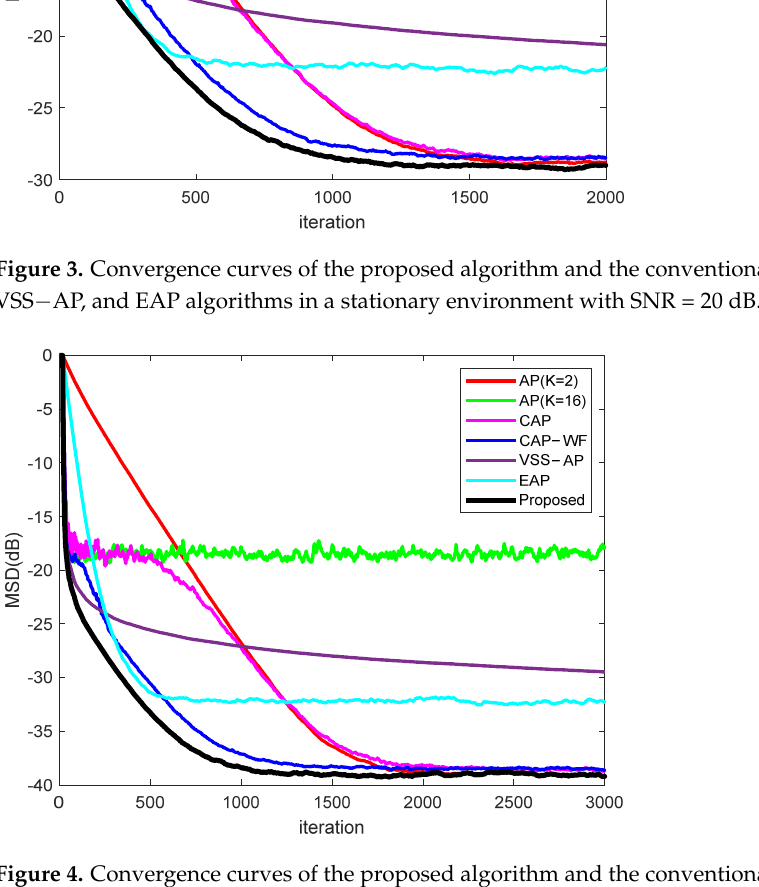
Figure 4. Convergence curves of the proposed algorithm and the conventional AP, CAP, CAP − WF, VSS − AP, and EAP algorithms in a stationary environment with SNR = 30 dB.